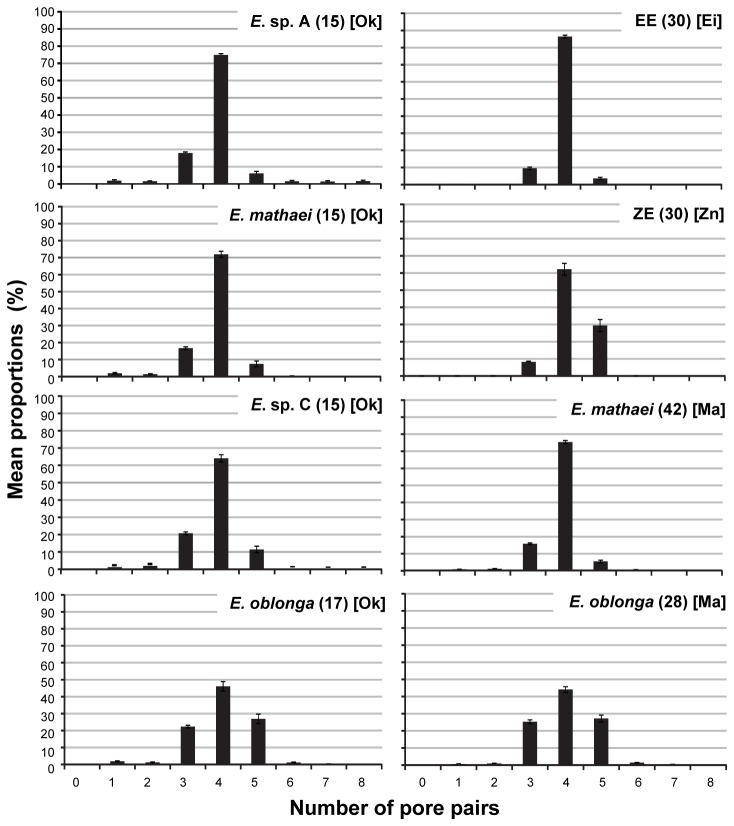
Pore-pairs ratios of Echinometra from Eilat, Zanzibar, Okinawa and Mauritius.Mean proportion ± SE (%) of pore-pairs in Echinometra species from Eilat [Ei], Zanzibar [Zn], Okinawa [Ok], and Mauritius [Ma]. Figures in parentheses represent sample sizes. Raw data on Okinawan and Mauritian Echinometra courtesy of Yuji Arakaki.